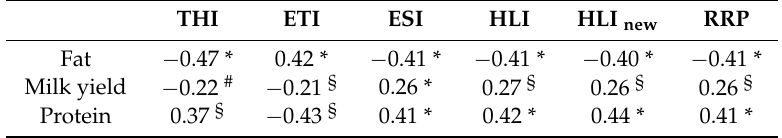
Table 1. Correlation between climate indices (Temperature Humidity Index (THI),